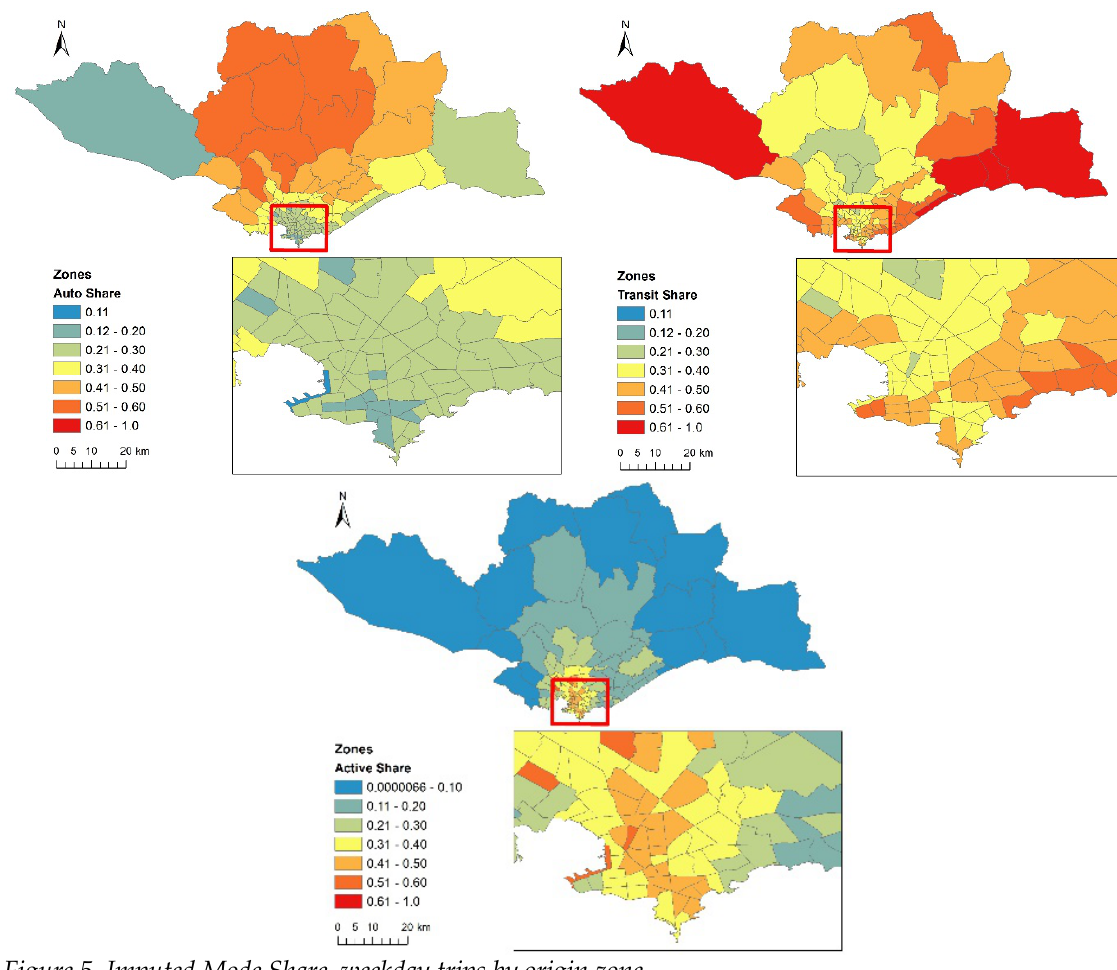
Figure 5. Imputed Mode Share, weekday trips by origin